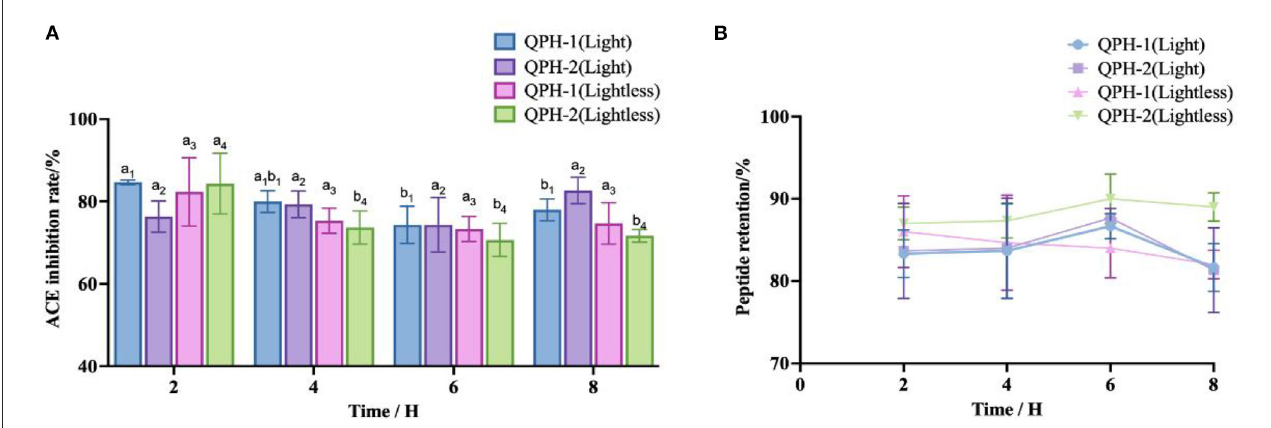
FIGURE9 (A) ACE inhibition of samples treated with different light conditions and lengths of time. (B) Peptide retention of samples treated with different light conditions and different lengths of time. Different letters indicates the significant differences among samples ( p -value ≤ 0.05).